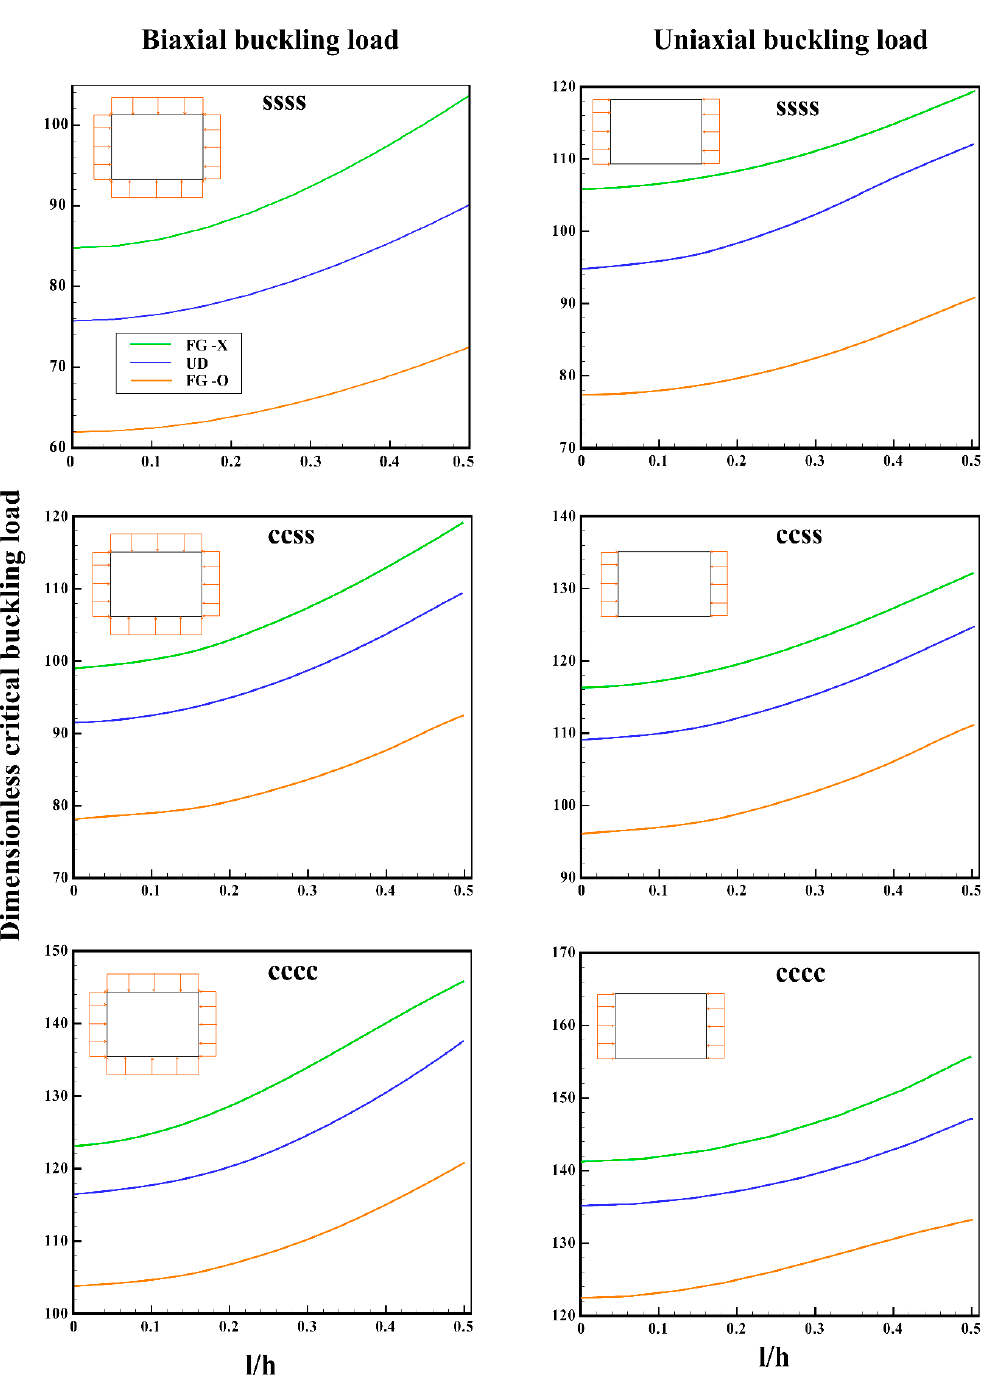
Figure 6. The effects of the CNT distributions on the uniaxial and biaxial buckling loads of the FG-CNTRC microplate against the material length scale parameter to thickness ratio (uniform edge compressive load).